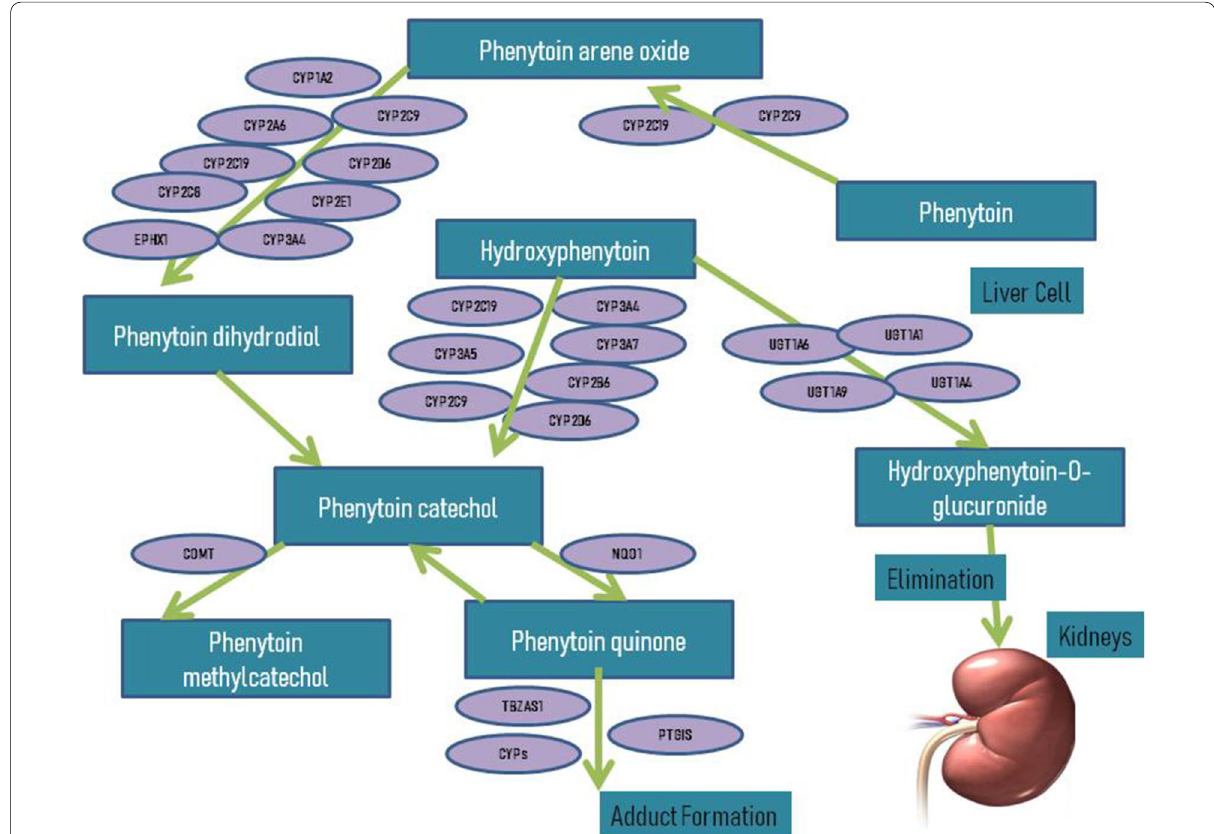
Fig. 1 Diagram of genes involved in the metabolism of phenytoin in a human liver